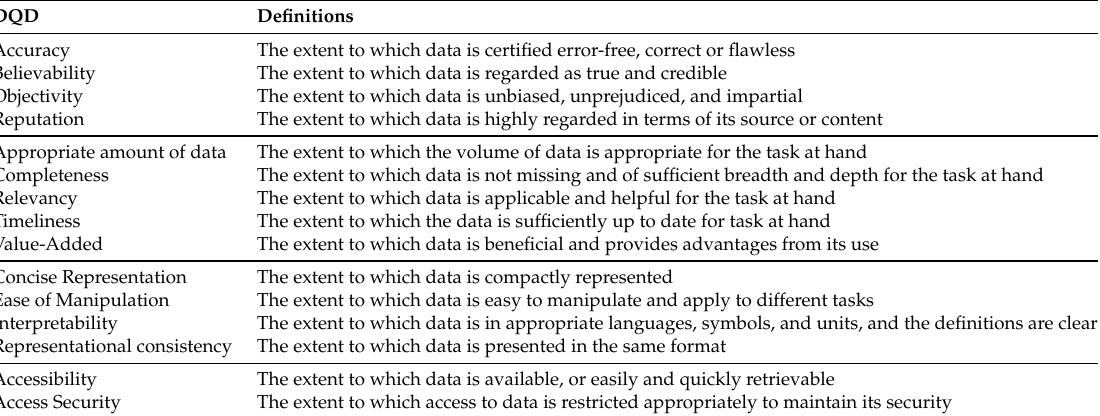
Table 1. DQDs and their corresponding definitions (adapted from Leo et al.